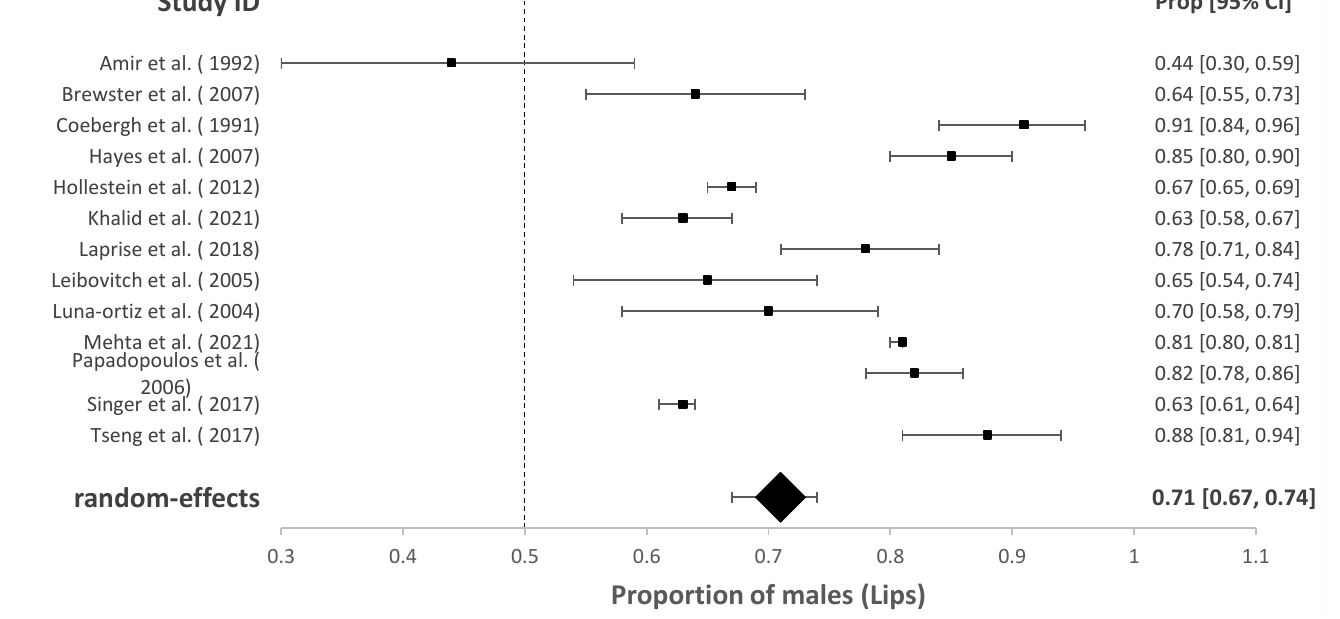
Figure 4. Proportion of males with cSCC of lips.[17,21,23,35,38,45,48,49,51,54,62,70]